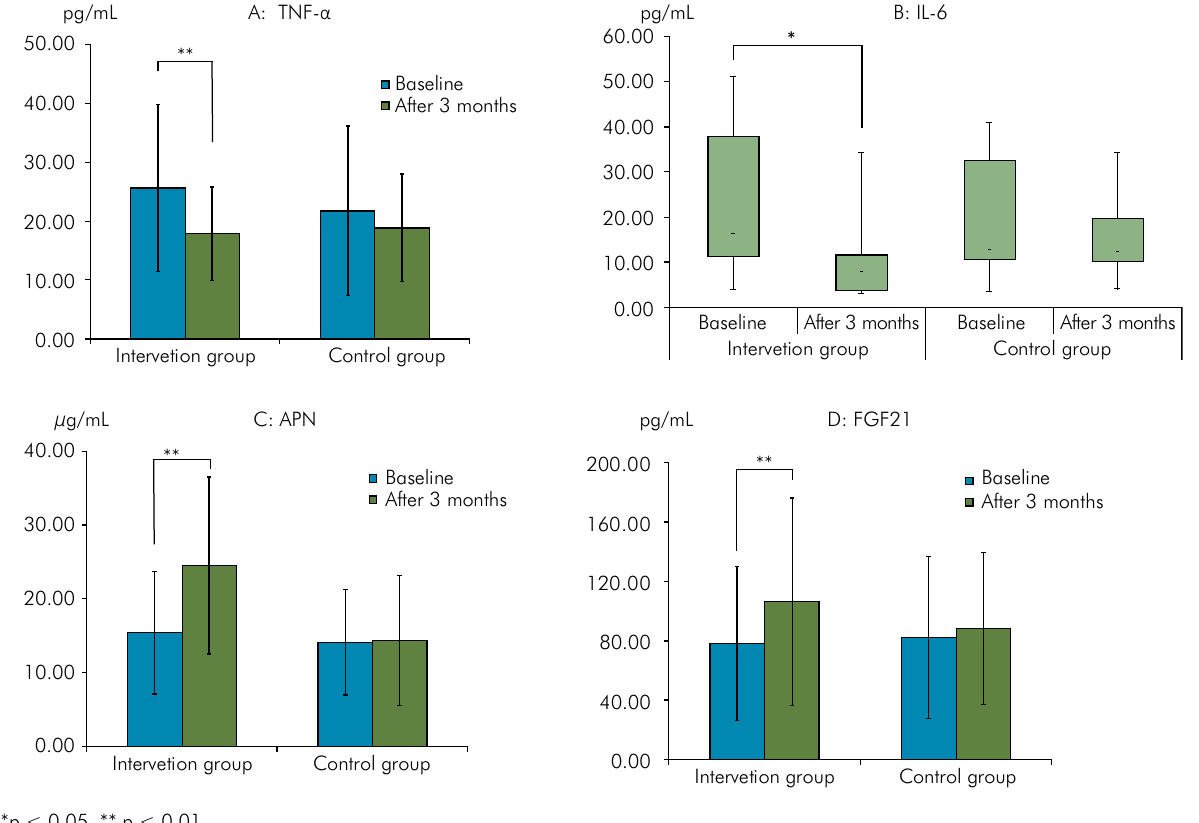
Figure 2. Serum TNF- α , IL-6, APN, and FGF21 concentrations in the two groups at baseline and after 3